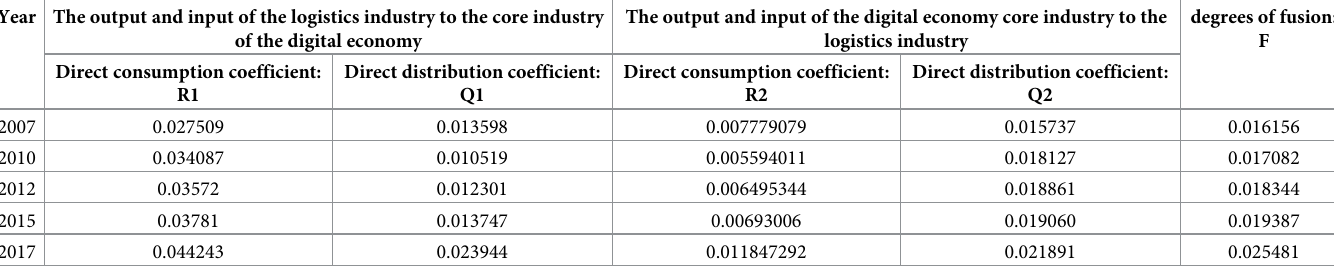
Table 1. Integration degree of the core industry and logistics industry in China’s digital economy. Year The output and input of the logistics industry to the core industry The output and input of the digital economy core industry to the of the digital economy logistics industry